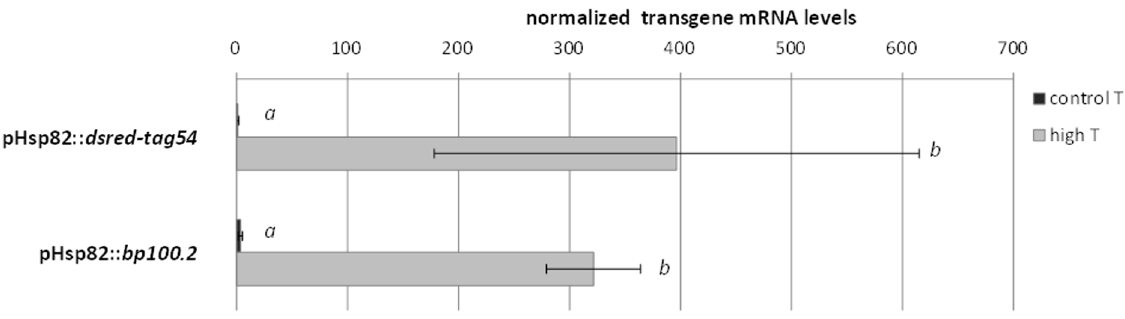
Figure 5. Transgene mRNA expression levels in leaves of GM rice plants harboring pHsp82:: bp100.2 or pHsp82:: dsred-tag54 constructs. Three independent events of each construct were analyzed. For each event, T 1 seeds were germinated under control conditions and sets of eight plants at the V2 stage were either subjected to 42 u C for 2 h (black bars) or not (grey bars), and their leaves individually sampled. Sets of five plants harboring the transgene (i.e. giving positive transgene signal using the Phire Plant kit) were collectively analyzed by RT-qPCR targeting the sequence encoding DsRed-tag54 or BP100.2, and normalized against ef1 a . Mean and SD values corresponding to every transgene are shown. Different letters indicate statistically different transgene mRNA values (One-way ANOVA, Tukey’s b posttest a , 0.05).